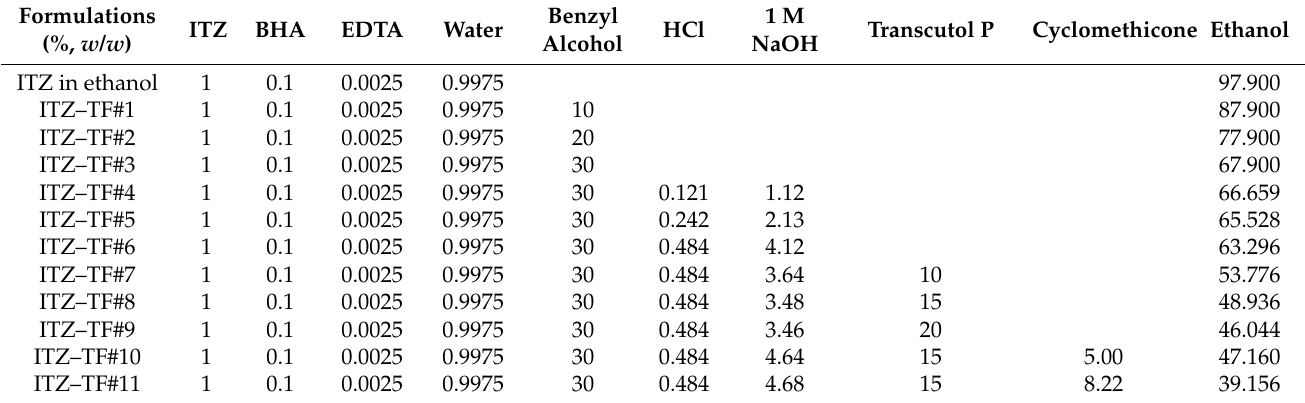
Table 1. Compositions of topical ITZ